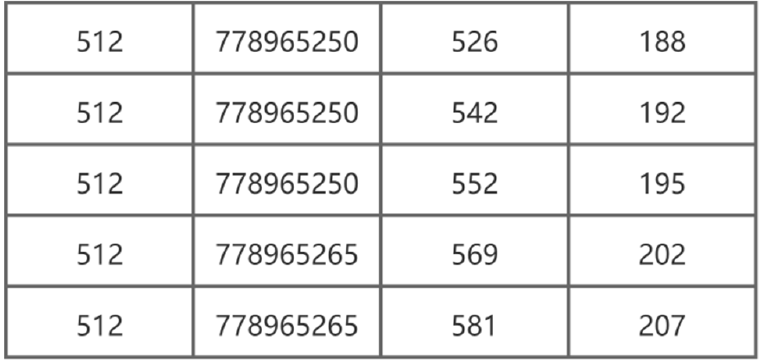
Figure 5. Example of collected mouse data.